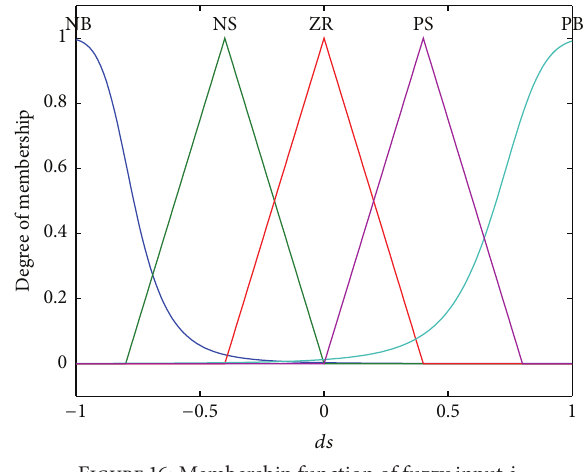
Figure 16: Membership function of fuzzy input ̇𝑠 .